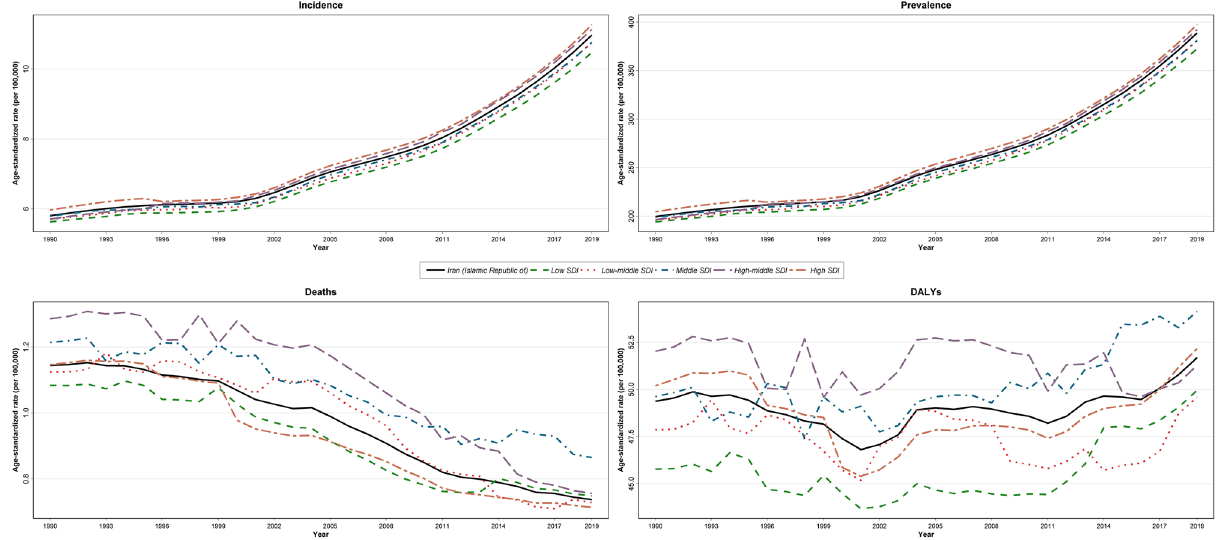
Figure 3. Time trend of age-standardized T1DM burden by SDI quintiles in the country from 1990 to 2019.